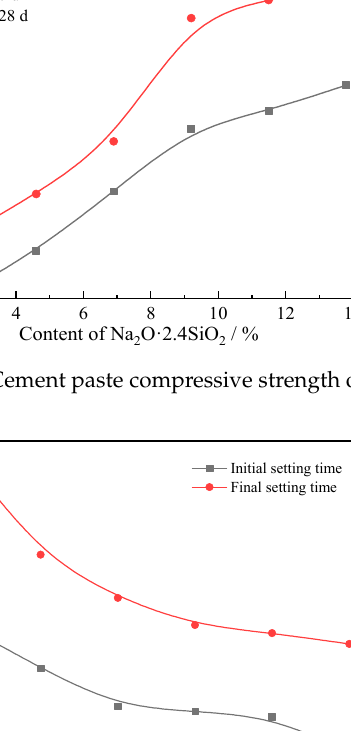
Figure 6. Cement paste compressive strength of composite alkali-activated cementitious material.